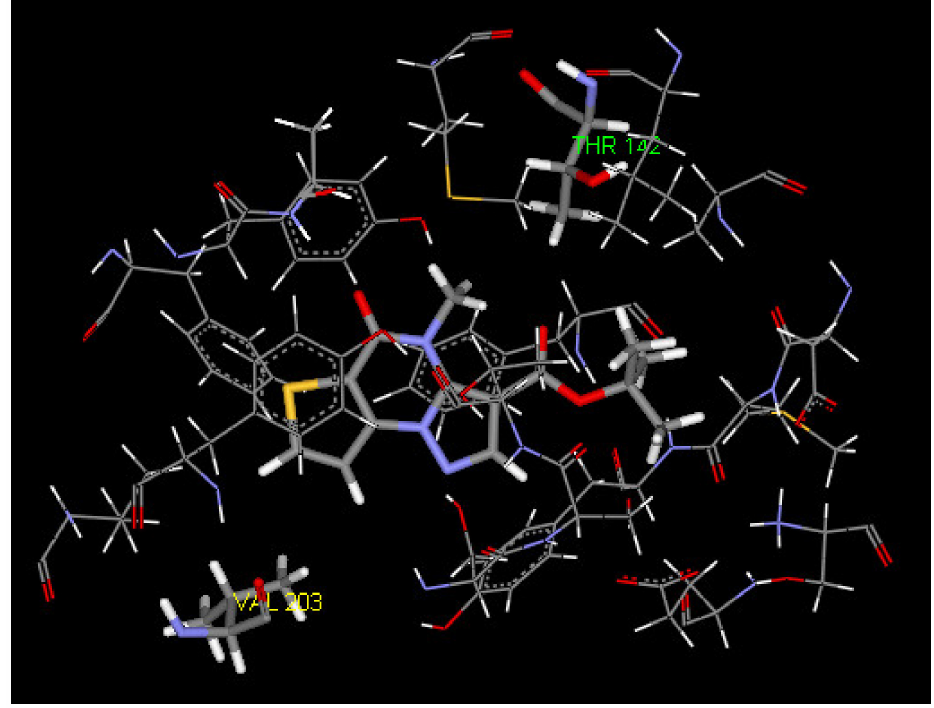
Figure 8. Hydrogen bond interaction of compound 22a in the last frame of dynamic